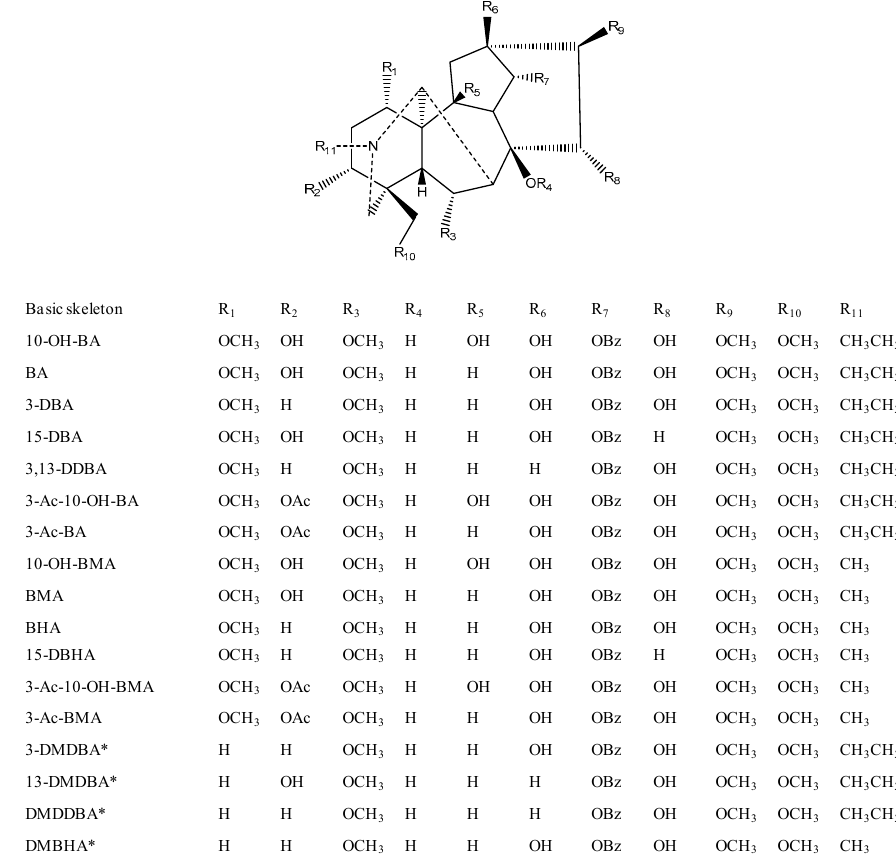
Figure 5. Structures of aconitane skeletons of lipo-alkaloids. * Indicates the skeleton was detected for the first time.